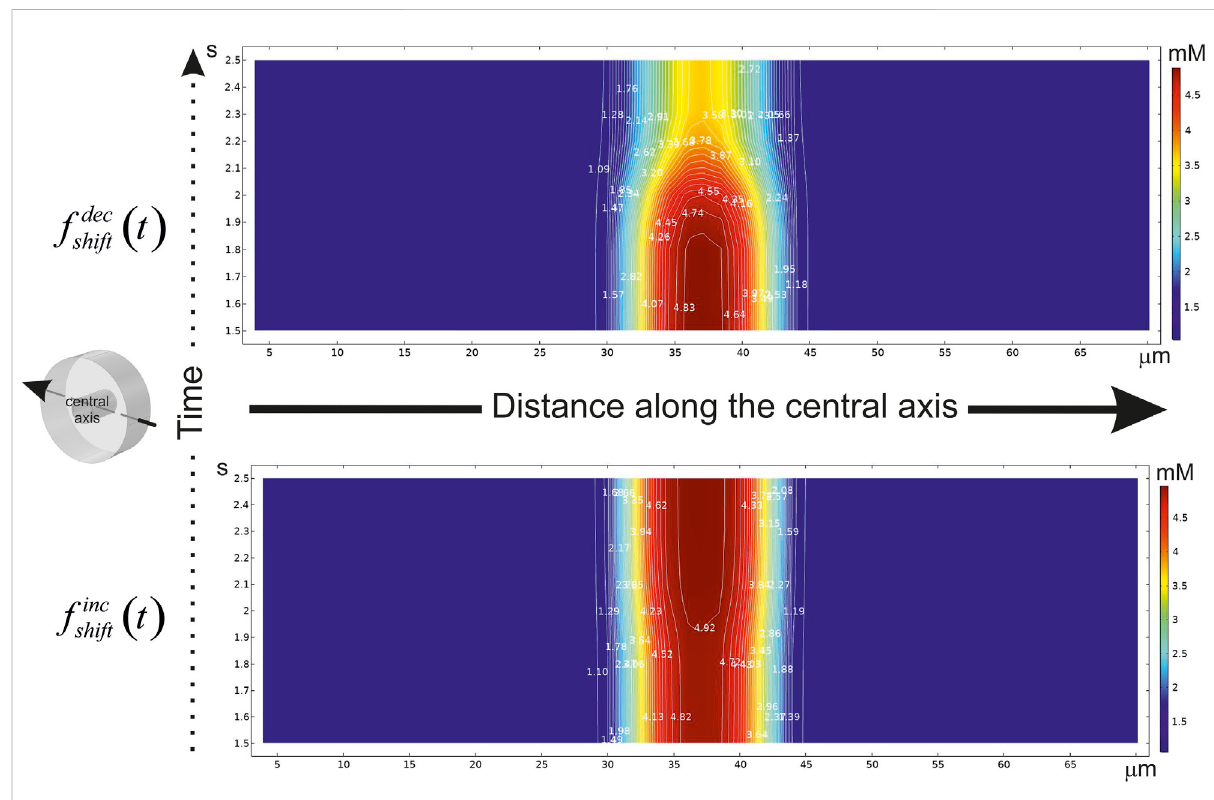
FIGURE 5 A diagram of the glucose concentration changes after CBF shift in time. The abscissa indicates the distance ( μ m) along the central axis penetrating the virtual phantom at mid-points of X and Y. The axis position is hinted in an isometric illustration in the left. The ordinate indicates the timescale(s).Ifthestep-likefunctionhadbeenapplied,CBFeithertobedecreased( f dec shift ( t ) ,top)ortobeincreased( f inc shift ( t ) ,bottom).Whitelineswith the numbers draw the isolines of the same glucose concentration. The diagrams are represented for δ end − feet =